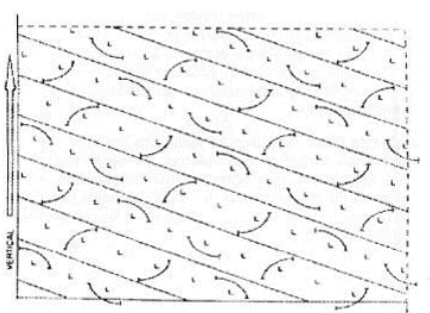
FIGURA 2 – Sistema-teste tipo ciclóide, utilizado na análise estereológica, sob aumento de 500X.